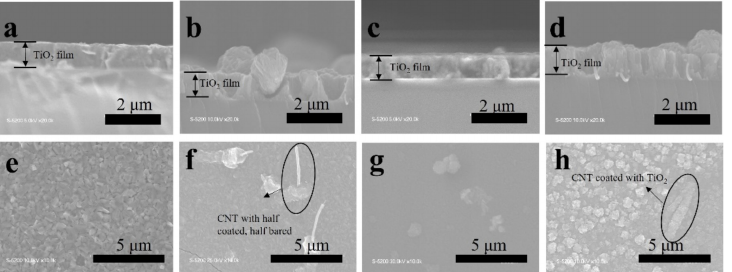
Figure 2. SEM images of the prepared films. Cross-sectional morphologies of ( a ) T, ( b ) T-C, ( c ) T-A, and ( d ) T-C-A0. Surface morphologies of ( e ) T, ( f ) T-C, ( g ) T-A, and ( h )